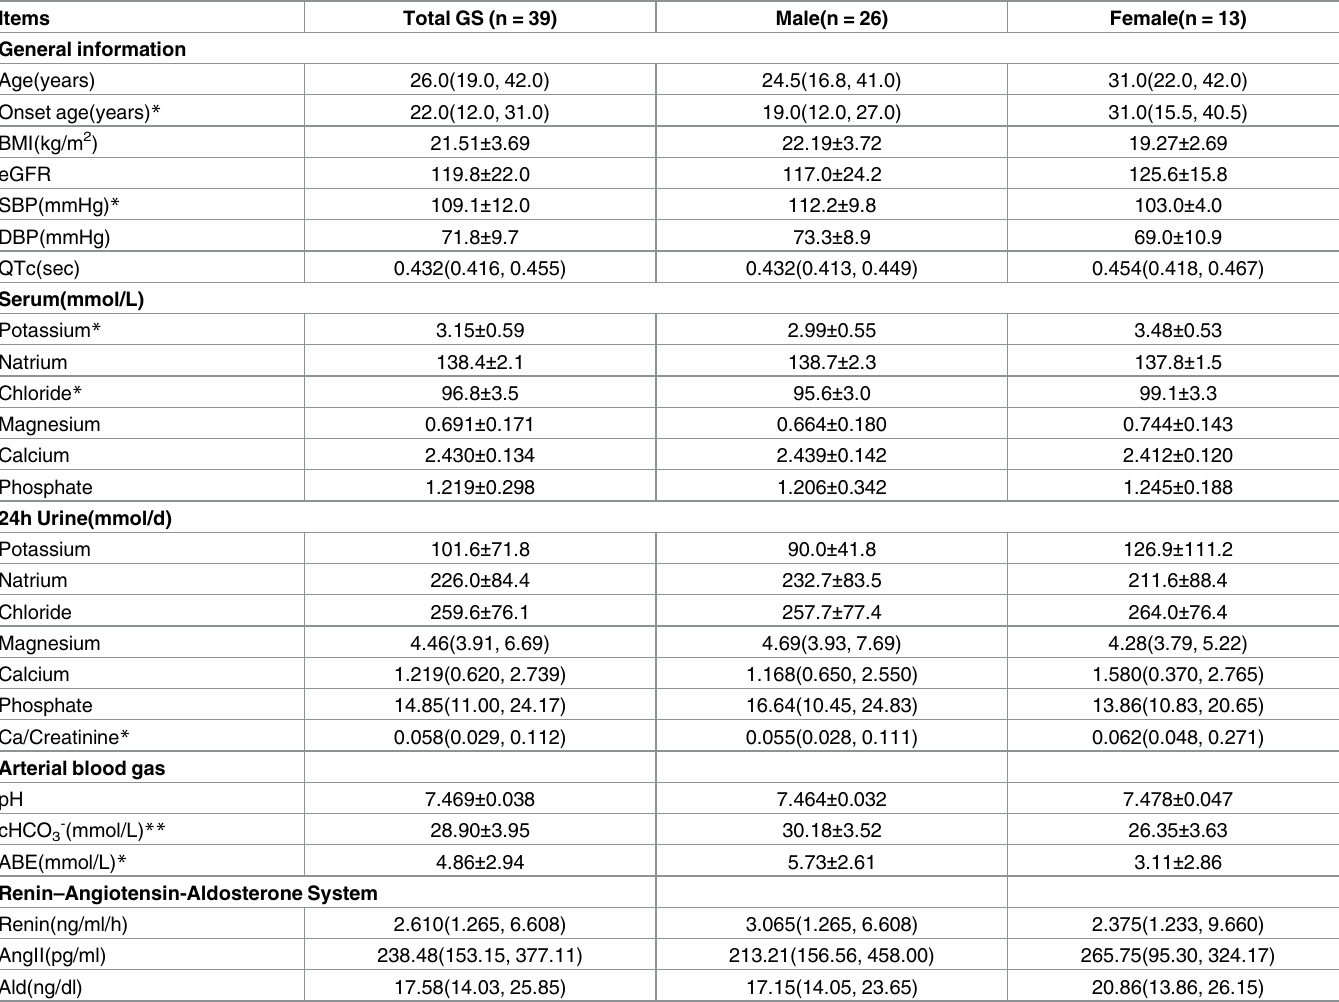
Table 1. Clinical and biochemical profile of GS